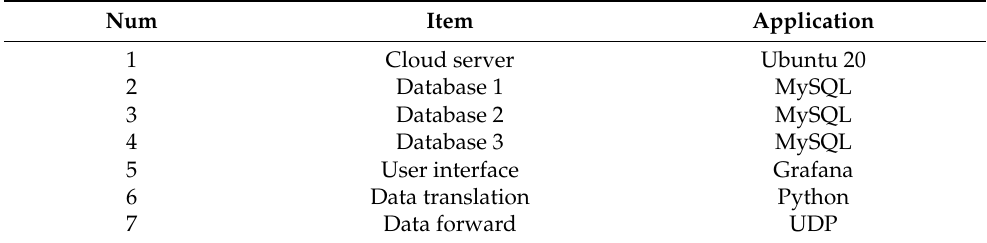
Table 3. Software deployed on cloud server.